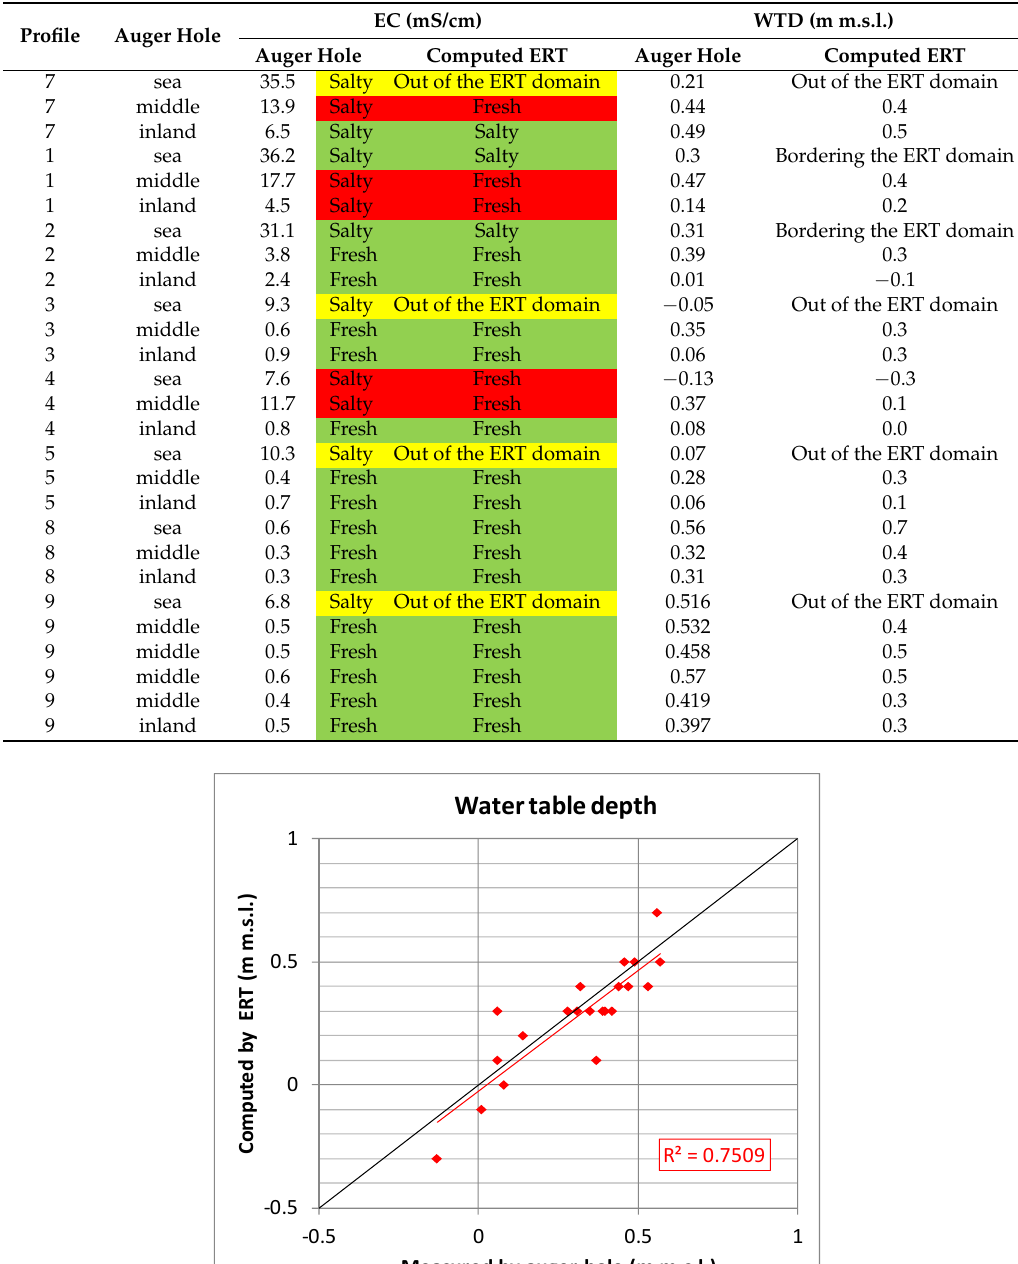
Table 2. Comparison between auger hole measured data and ERT data for all the investigated profiles. The red cells of the table represent poorly attributed EC by the ERT-inverted model; green cells represent correct EC attribution and yellow cells indicate no possible comparison.